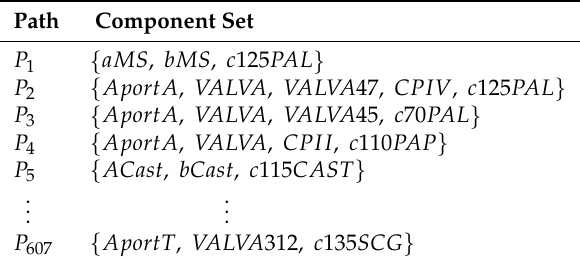
Table 5. Some success minimal paths of the Barcelona